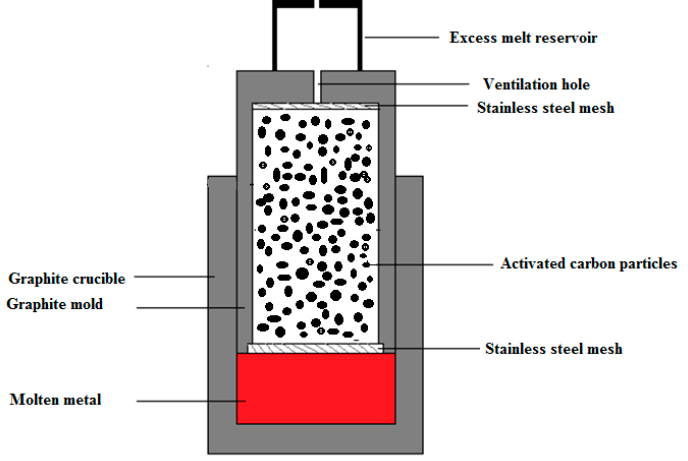
Figure 1. A schematic of the counter gravity infiltration casting technique.